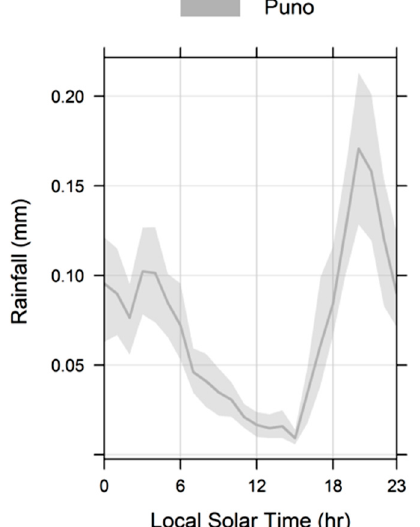
Figure 10. Mean diurnal cycle of summer precipitation at the automatic weather station (Puno). RgSENAMHI-Puno (thin gray solid line indicates 2014–2018). The abscissa represents the diurnal cycle phase (LST), and the ordinate represents the region’s average precipitation rate (units:mm d − 1 ).